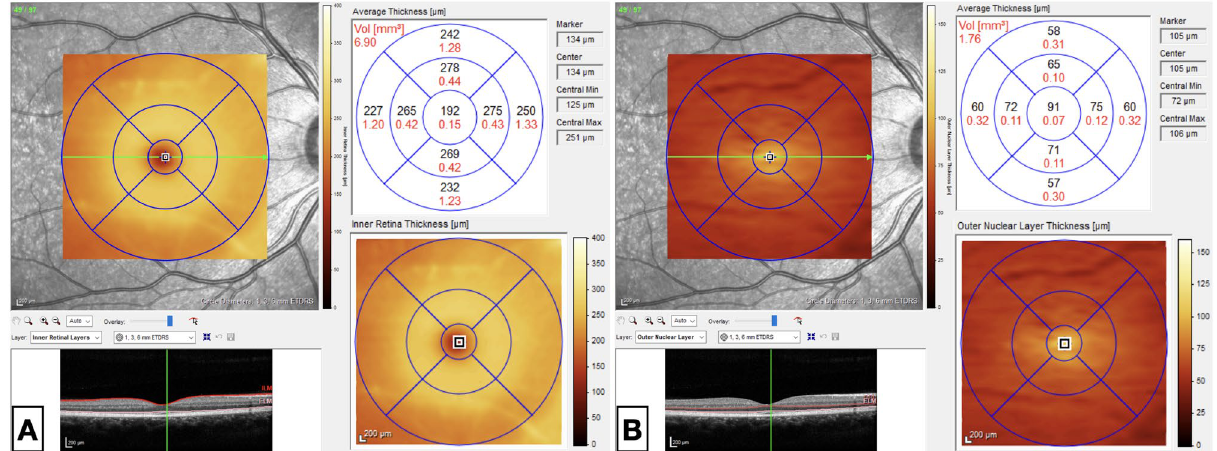
Figure 1. SD-OCT measurement of inner retinal thickness and volume* computed from the difference between ( A ) (Inner retinal layer = ILM + ELM) and ( B ) (Outer nuclear layer = OPL + ELM). SD-OCT spectral domain-